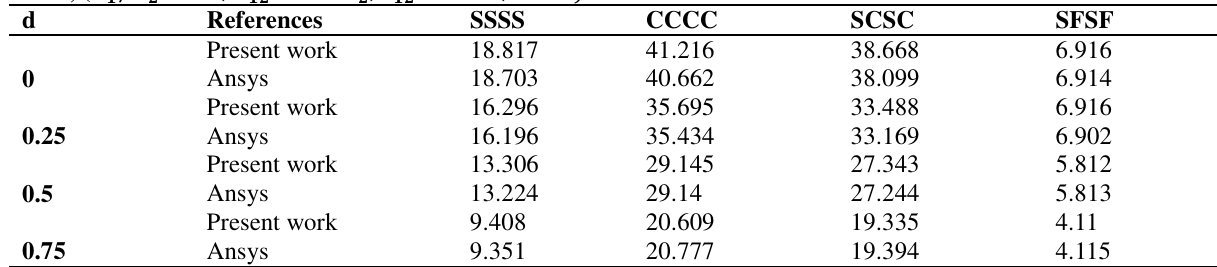
Dimensionless natural frequency ratios, (